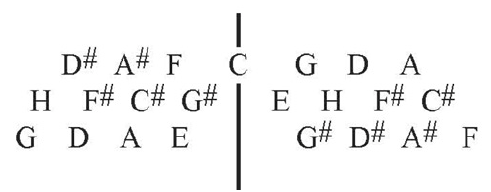
FIGURE 7. A reflection of the system around the tone